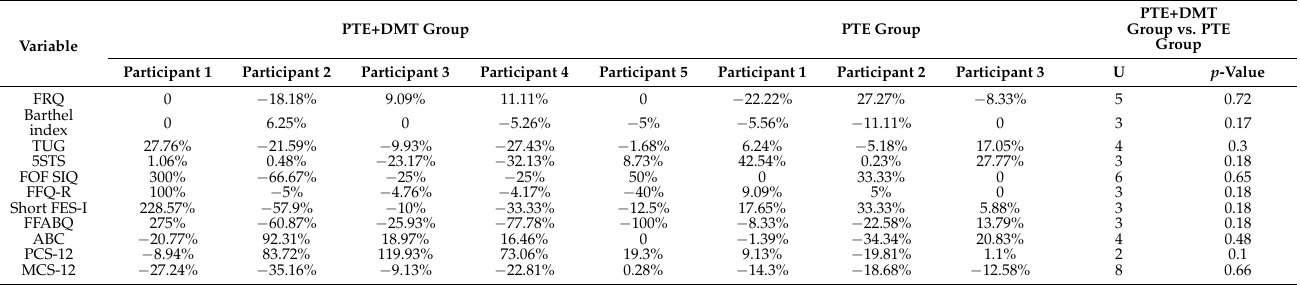
Table 3. Comparison of percentage changes between groups results expressed by Mann/Whitney U test.